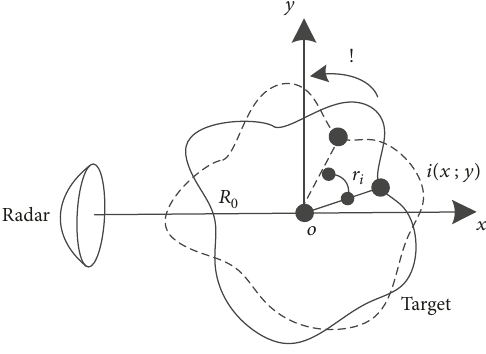
Figure 2: Geometry of ISAR